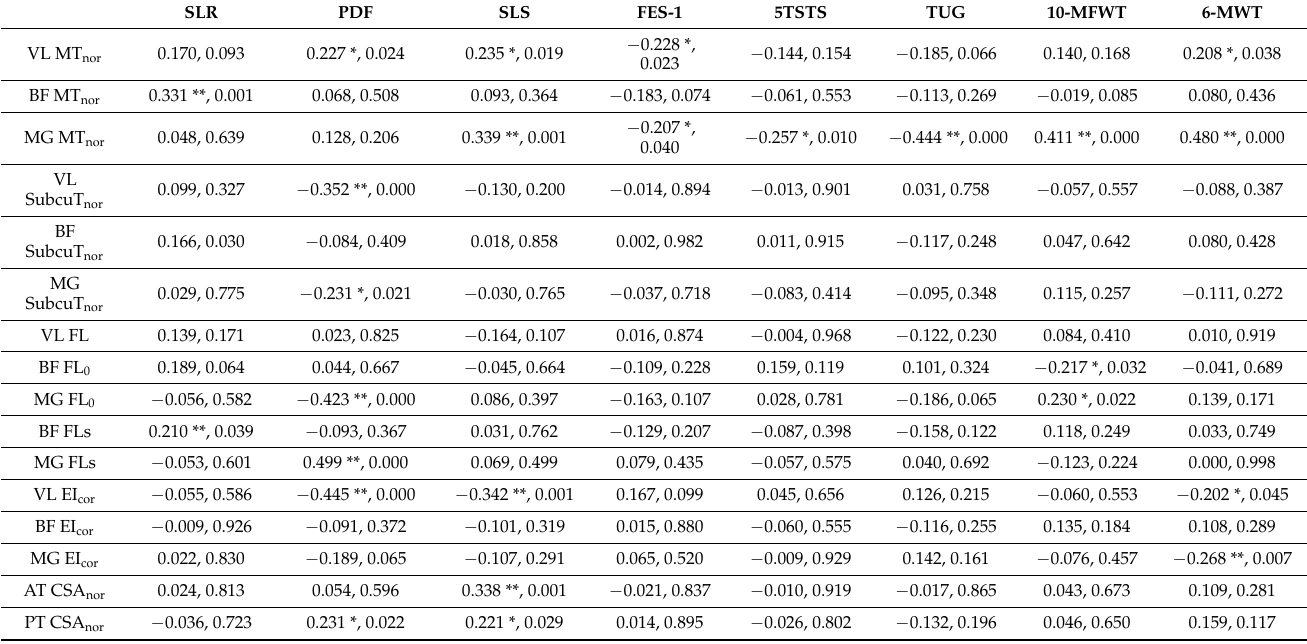
Table 3. Pearson correlation representing the association between musculotendinous morphology and other performance variables ( n =